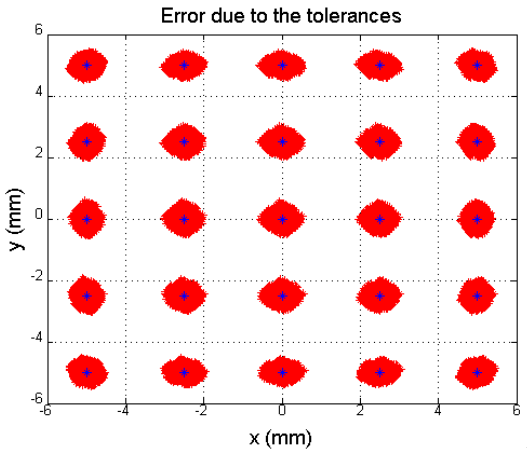
Figure 6. Simulation of the error in the point of incidence calculation due to tolerances.